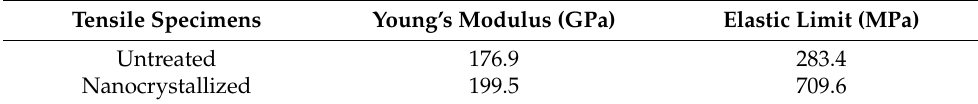
Figure 3. Stress – strain relation of hexagonal aluminum column. 2.3. Specimen Preparation The local nanocrystallized tubes are fabricated by welding two plates. Firstly, two stainless steel plates of SUS 304 are locally nanocrystallized by UIT. Next, each plate is bent to 120° along the bending lines. Then, two bent plates are welded into one thin-walled tube by argon-arc welding. The location for welding lines is in the middle of one side. Lastly, the foam column is filled into the local nanocrystallized tube to form a foam-filled tube, as shown in Figure 4. The geometrical parameters for the regular hexagonal tube are: side length of 26.7 mm, height of 80 mm and thickness of 0.7 mm. ( a ) ( b )